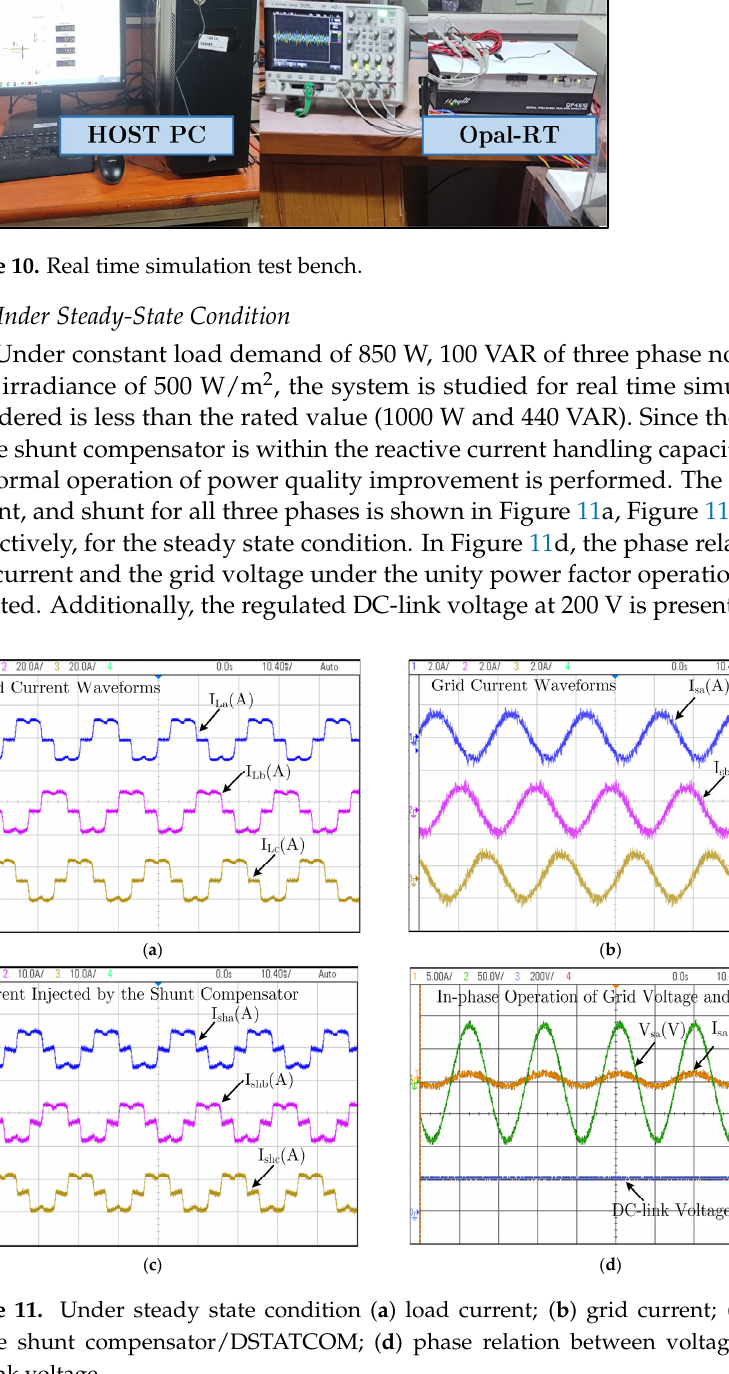
Figure 9. Phasor relation between grid current and grid voltage.